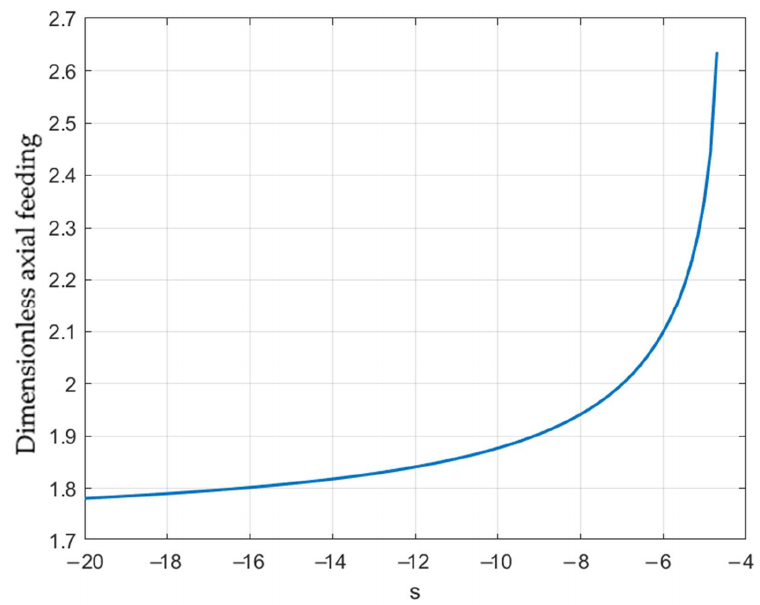
Figure 8. Effect of the loading path on fracture